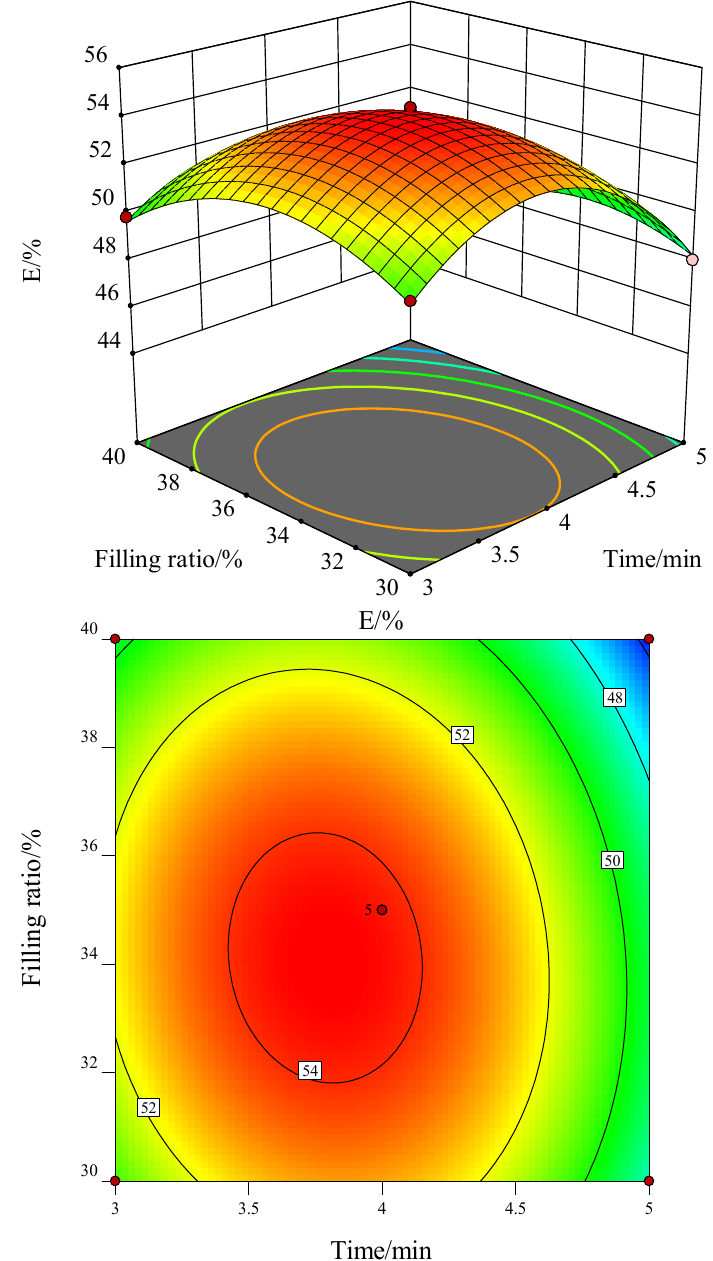
Figure 13. Response surface diagram and contour map at the action of grinding time and filling ratio.